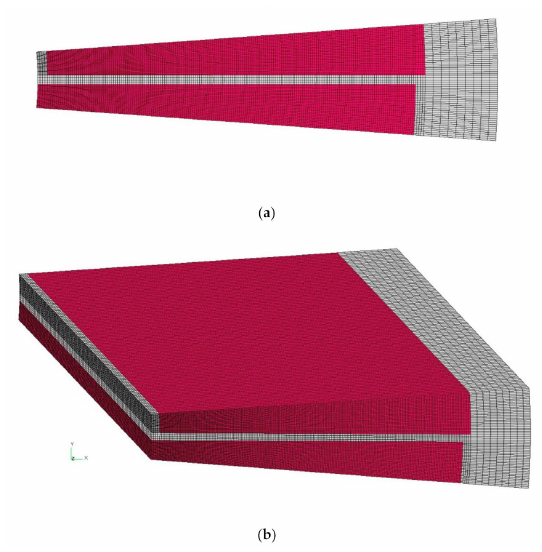
Figure 2. Grid system: ( a ) cross-sectional view and ( b ) three-dimensional